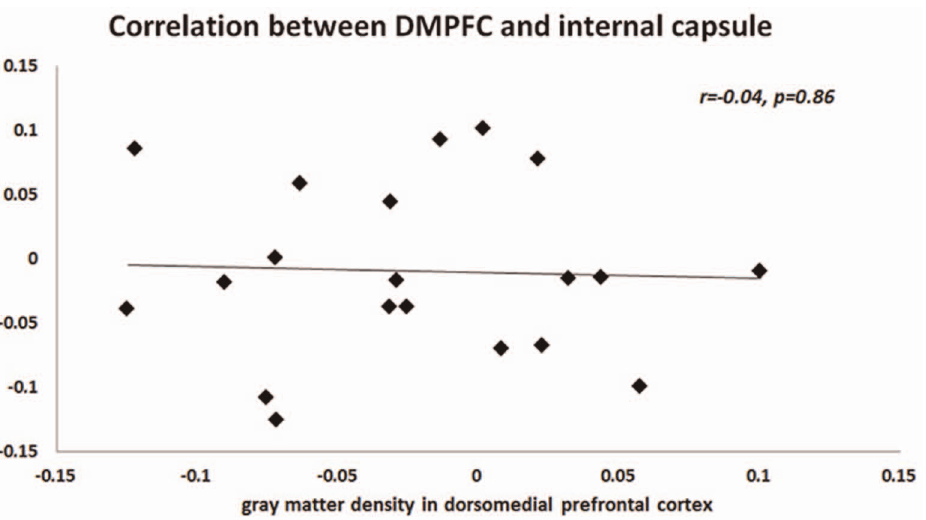
Figure 4. Unlike the correlation we found between gray matter structure in the M1 and the internal capsule, we found no correlation with gray matter density in the